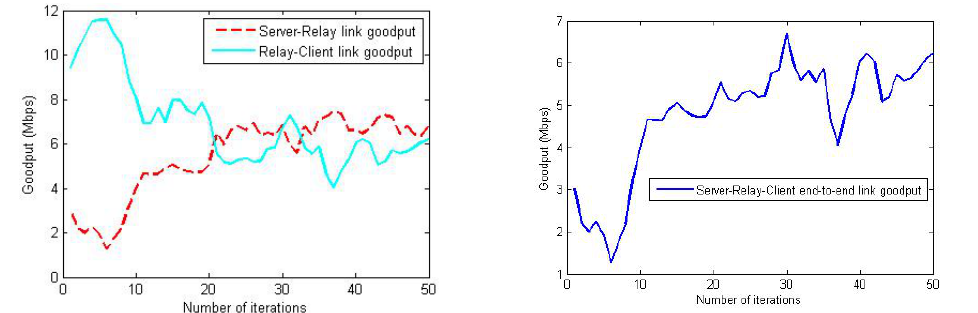
Figure 18. Change in the goodput values of server-relay, relay-client and end-to-end (server-client) links in one of the